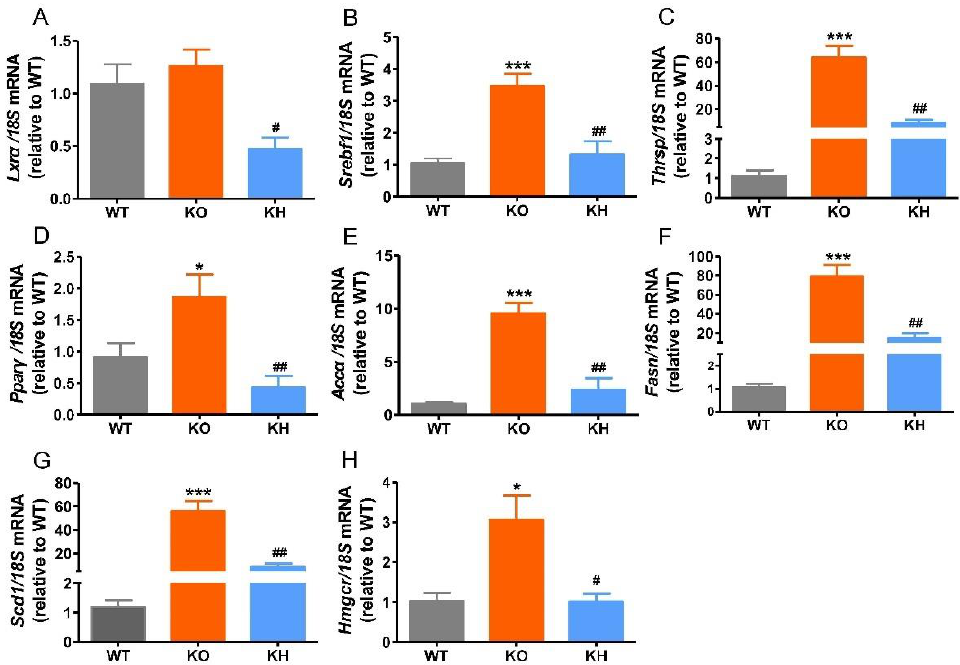
Figure 4. HTE reduced the expressions of hepatic lipogenesis related genes in Lepr −/− rats. ( A ) Lxrα ; ( B ) Srebf1 ; ( C ) Thrsp ; ( D ) Pparγ ; ( E ) Accα ; ( F ) Fasn ; ( G ) Scd1 ; ( H ) Hmgcr . * p < 0.05, *** p < 0.001, compared to WT group; # p < 0.05, ## p < 0.01 versus KO group ( n = 5, means ± SEM).